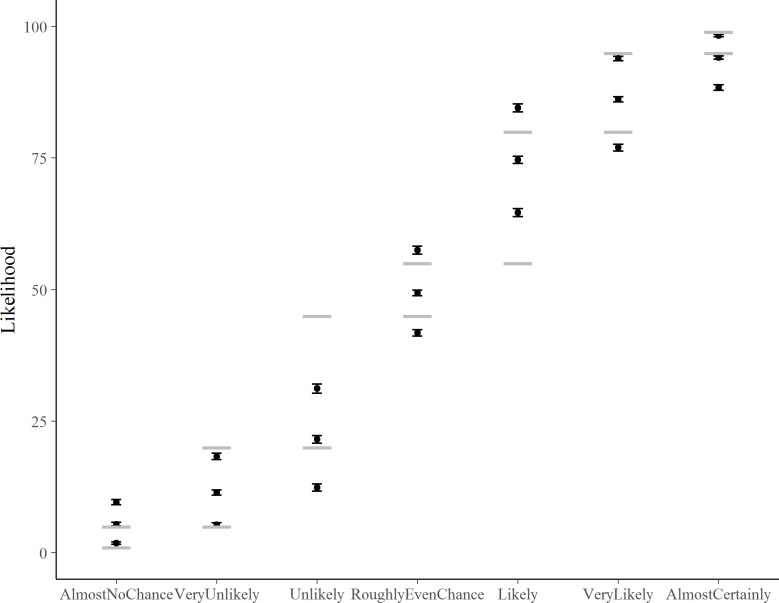
Correspondence between participants’ interpretation of seven context-free verbal probability phrases and the ICD 203 guidelines.The three sets of means (dots) and 95%CIs (error bars) for each phrase reflect the participants’ Minimum, Best estimate and Maximum judgements for that phrase. Dashed lines represent the ICD 203 guidelines.